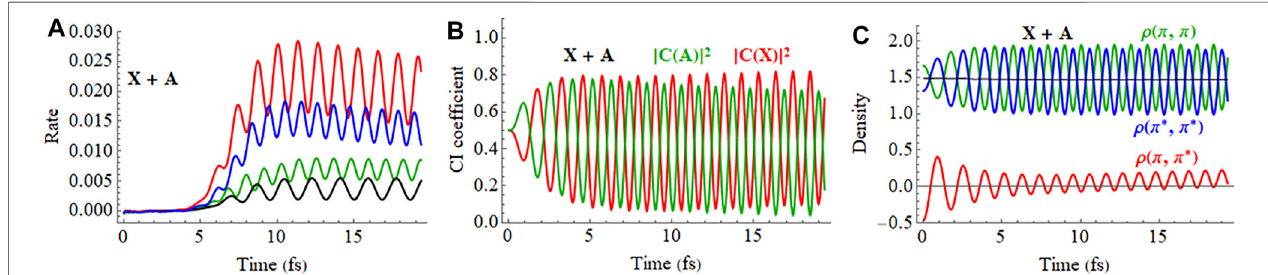
FIGURE7| Ionization oftheX +A ( (cid:2) π p − 1 x + (cid:2) π − 1 x )coherent superposition byastatic electric fi eldrampedup to0.055au. (A) Theionizationrate forthe fi eldalong the molecularaxisandionizationfromtheiodineend(blue)andthehydrogenend(green),perpendiculartothemolecularaxis(black)andat45 ° tothemolecularaxisfromthe iodine end (red). (B) CI coef fi cients for the X and A con fi gurations (red and green, resp.) in the normalized wavefunction for the X + A coherent superposition for the fi eld alongthemolecularaxisandionizationfromtheiodineend. (C) Densitymatrixelementsforthe π x and π p x orbitalsforthe fi eldalongthemolecularaxisandionization from the iodine end (a movie of the hole density is available in Supplementary Figure S2 of the Supporting Information).